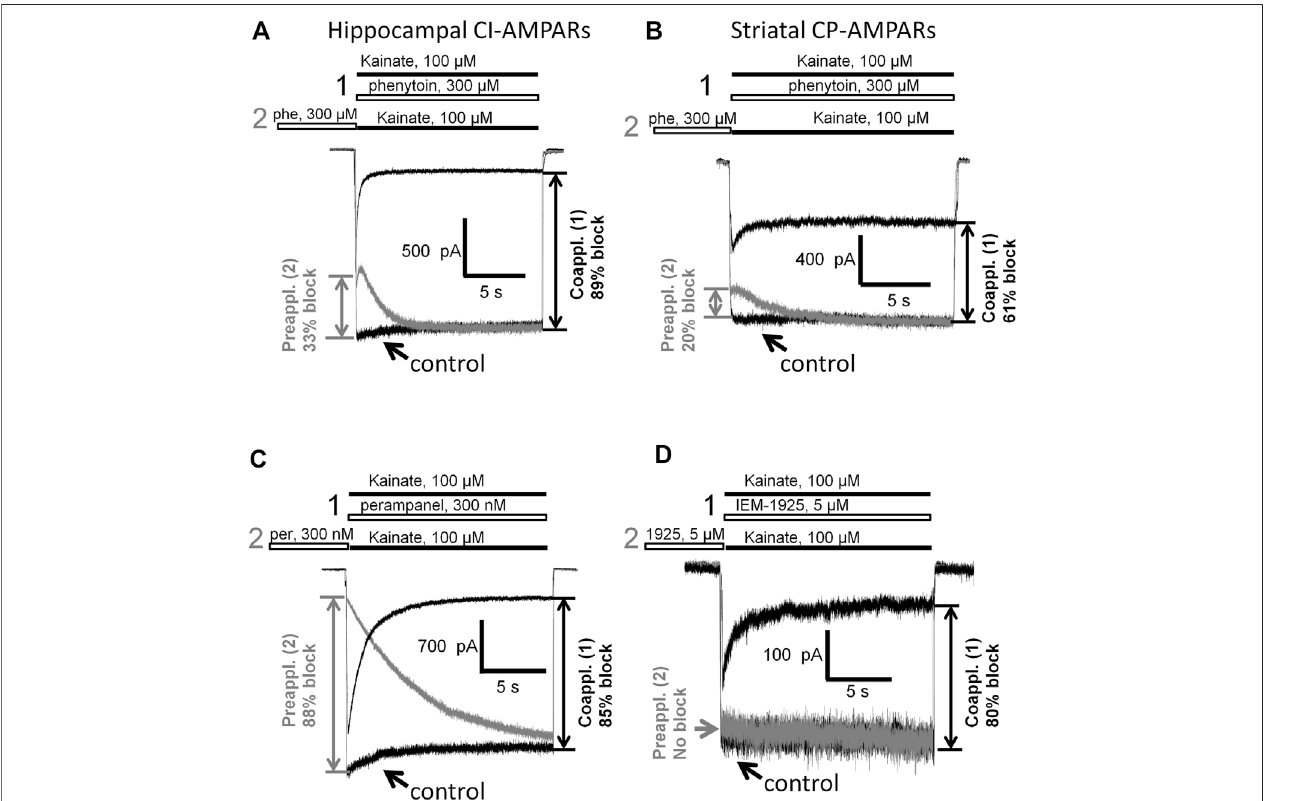
FIGURE 9 | Closed and open channel AMPAR inhibition by phenytoin, perampanel, and IEM-1925. (A,B) Comparison of the effects of 300 µM phenytoin on CI- AMPARsofhippocampalpyramidalneurons (A) andCP-AMPARsofstriatalgiantinterneurons (B) incaseofcoapplicationwithkainate(black traces)andpreapplication without kainate (gray traces). Forboth receptor types, phenytoin is more effectivein the coapplication protocol. (C) Comparison ofthe effects of 300 nM perampanel on CI-AMPARs of hippocampal pyramidal neurons in case of coapplication with kainate (black trace) and preapplication without kainate (gray trace). Perampanel is equally effective in these two protocols. (D) Comparison of the effects of 5 µM IEM-1925 on CP-AMPARs of striatal giant interneurons in case of coapplication with kainate (black trace) and preapplication without kainate (gray trace). IEM-1925 is effective only in the coapplication protocol.